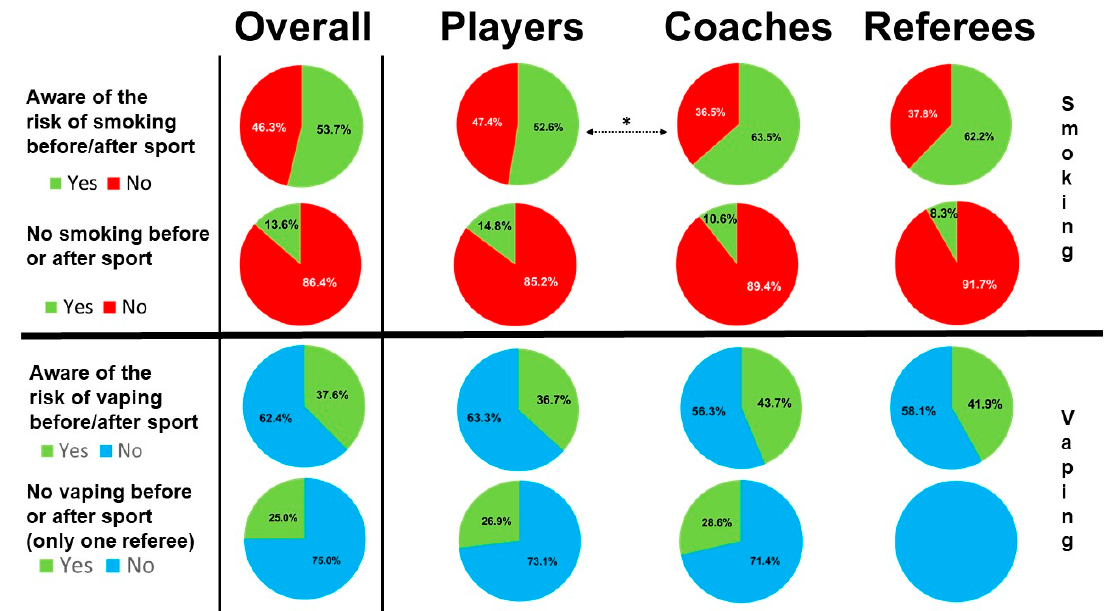
Figure 5. Level of knowledge on the risks of smoking (upper part) or vaping (lower part) in the setting of a rugby session (before/after) and related behaviors in the whole study population and according to category of rugby practice (* p < 0.05 ). Green color indicates a healthy attitude/behavior, and red or blue colors indicate an unhealthy attitude/behavior.